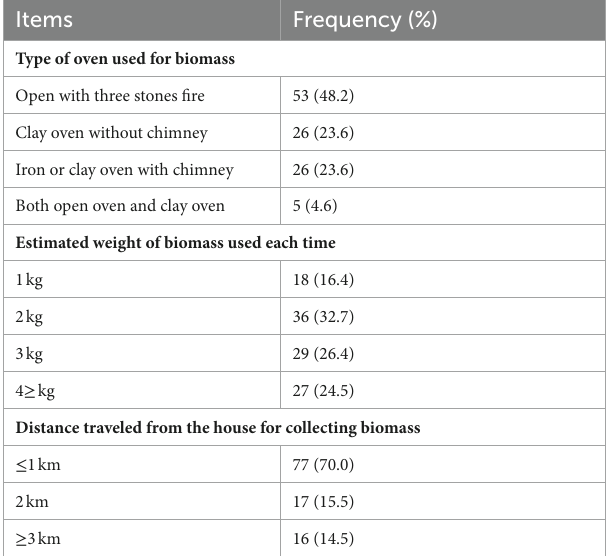
TABLE 3 Type of ovens and amount of biomass used by